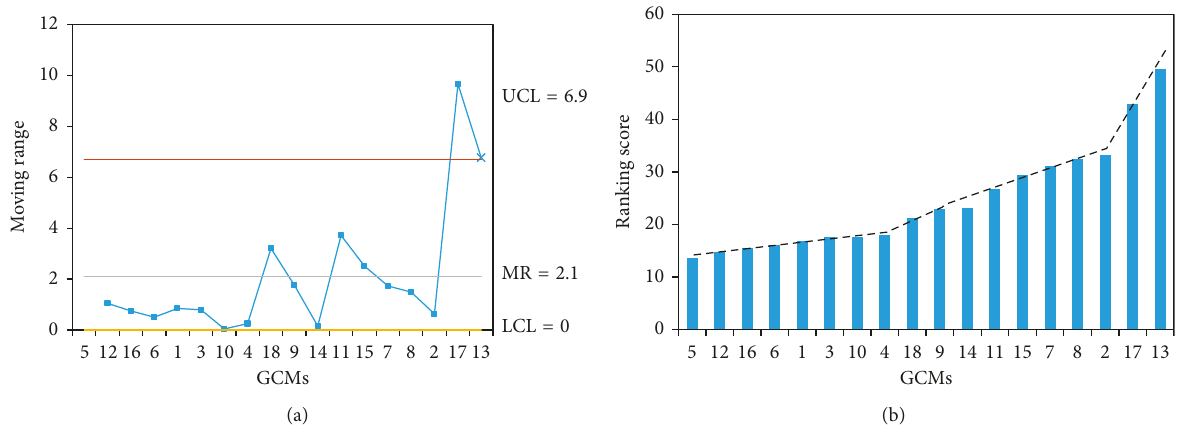
Figure 11: Moving test and breaking points of temperature via GCMs: (a) moving range for temperature and (b) breaking point of ranking scores for temperature.